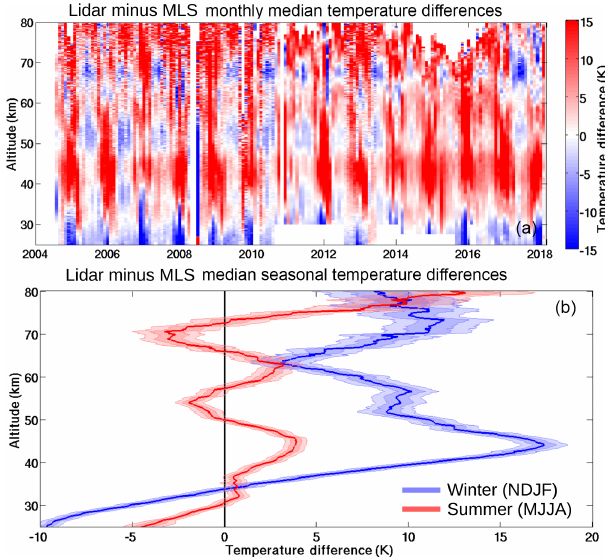
Figure 5. The 14-year systematic comparison of OHP lidars and MLS temperatures. The monthly median temperature differences between the lidars and MLS are shown in panel (a) . There are 1741 nights of coincident measurements. Panel (b) is a seasonal ensemble of lidar minus MLS temperature differences. The sum- mer (May, June, July, August) ensemble in red includes 554 nights of coincident measurements and the winter (November, December, January, February) ensemble in blue includes 653 nights of coinci- dent measurements. Shaded errors represent 1 and 2 standard devi-